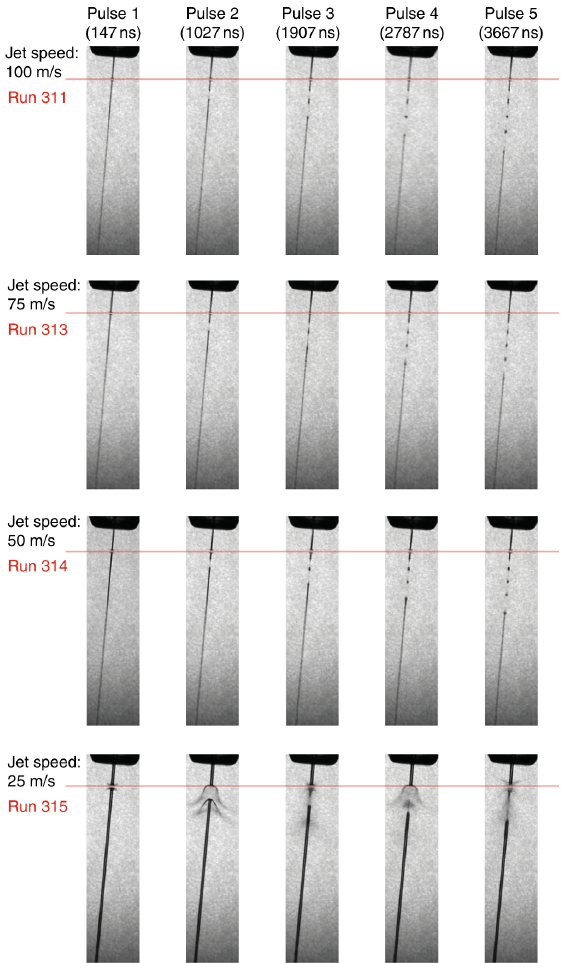
Figure 3. Pulsed illumination of the sample interaction region shows how X-ray pulses vaporize the sample, creating voids. Jet speeds of 100, 75, and 50 m s − 1 refresh the interaction region before the arrival of the subsequent pulse. It can be seen that the lower limit for 1.1 MHz operation falls between 25 and 50 m s − 1 . Figure originally published in Nat. Commun.